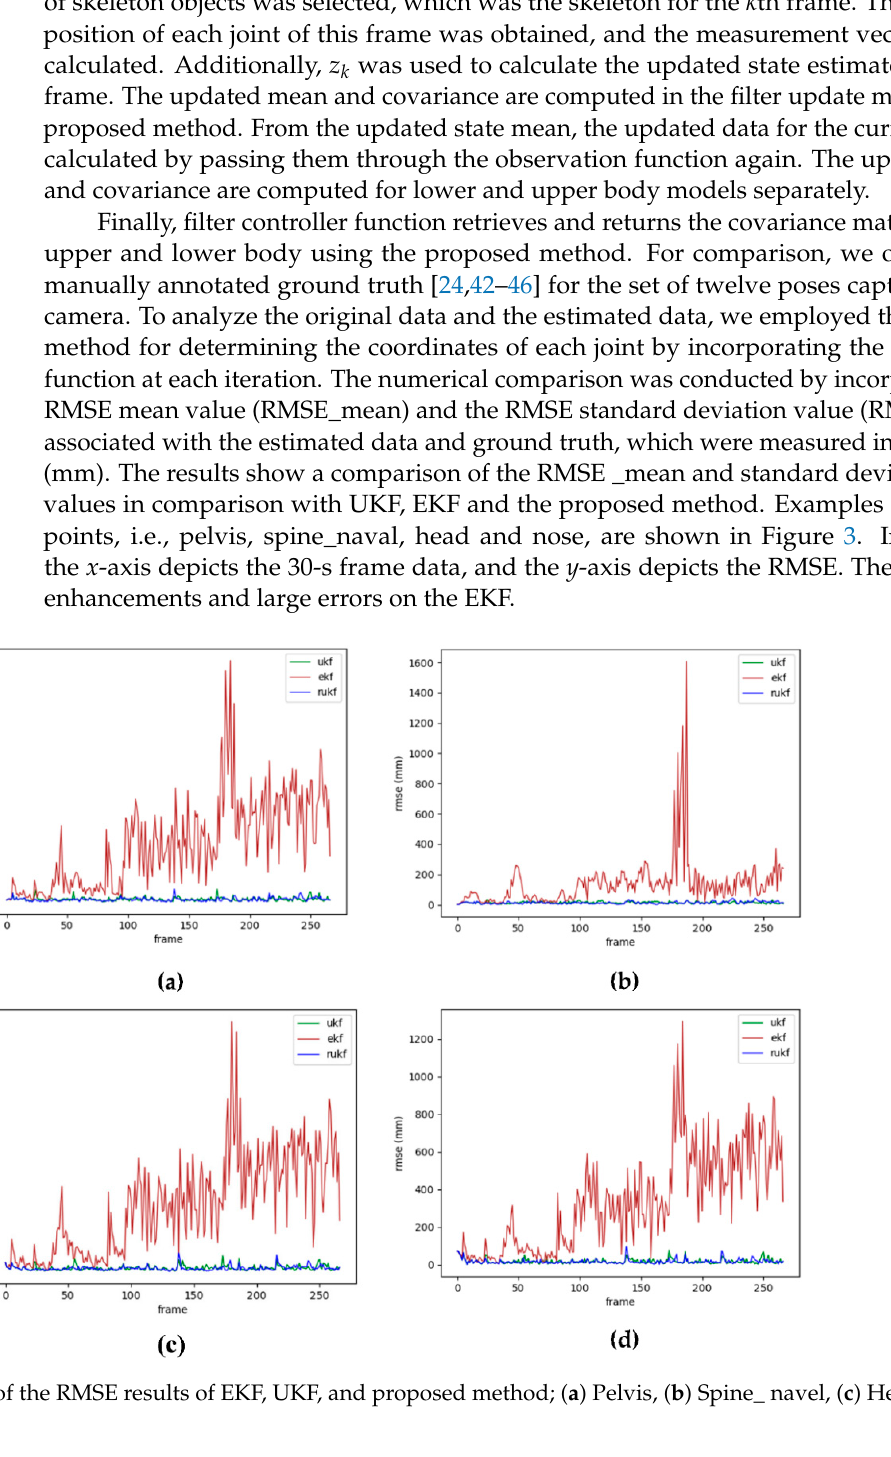
Table 1. Results of RMSE_mean and RMSE_(±SD) of skeleton joints for each method.